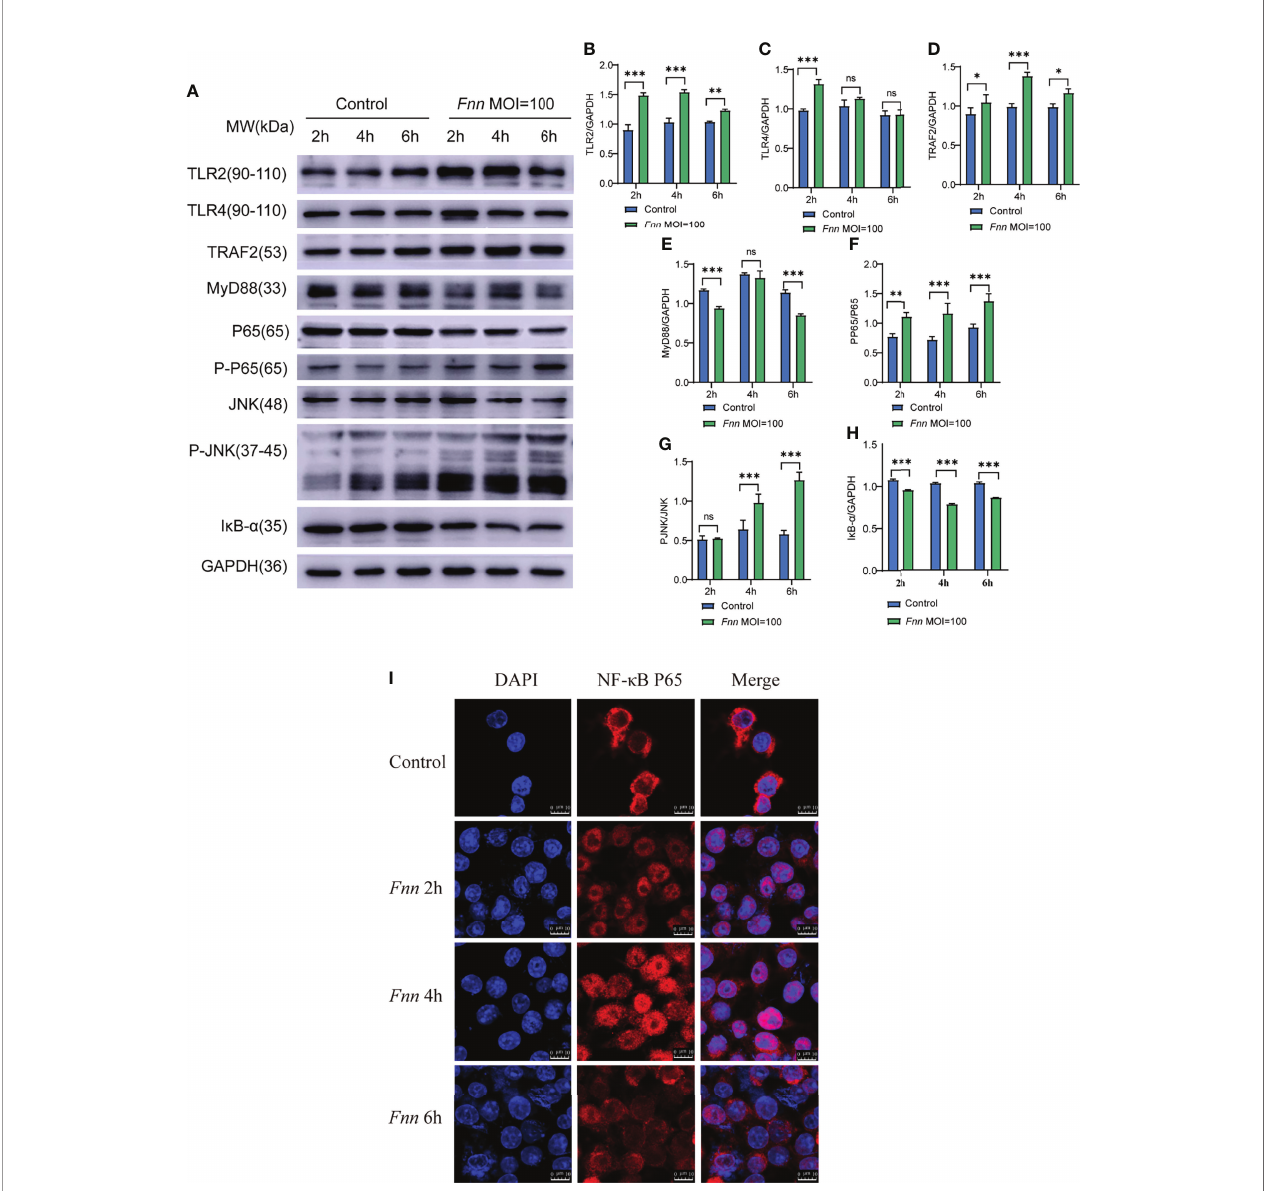
FIGURE 9 | The effect of F. necrophorum on NF- k B and death receptor signaling pathways of macrophages was detected by Western blot and Immuno fl uorescence. (A) The protein levels of TLR2, TLR4, TRAF2, MyD88, NF- k B p65, phosphorylated NF- k B p65, JNK, phosphorylated JNK, and I k B a were detected by Western blot. TLR2 (B) , TLR4 (C) , TRAF2 (D) , MyD88 (E) , phosphorylated NF- k B p65/NF- k B p65 (F) , phosphorylated JNK/JNK (G) , and I k B a (H) was detected. Immuno fl uorescence images of NF- k B p65 in cells (I) ( n = 3). * P <0.05, ** P <0.01, *** P <0.001, ns, not signi fi